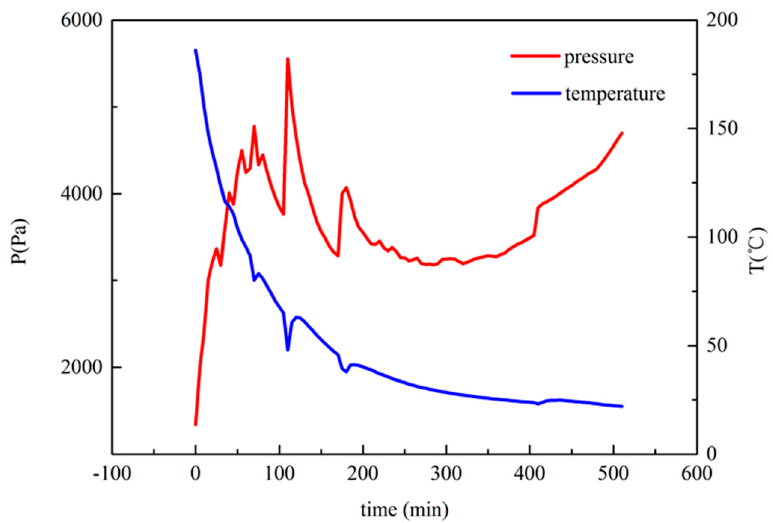
Figure 8. Variation of temperature and pressure during the adsorption process.